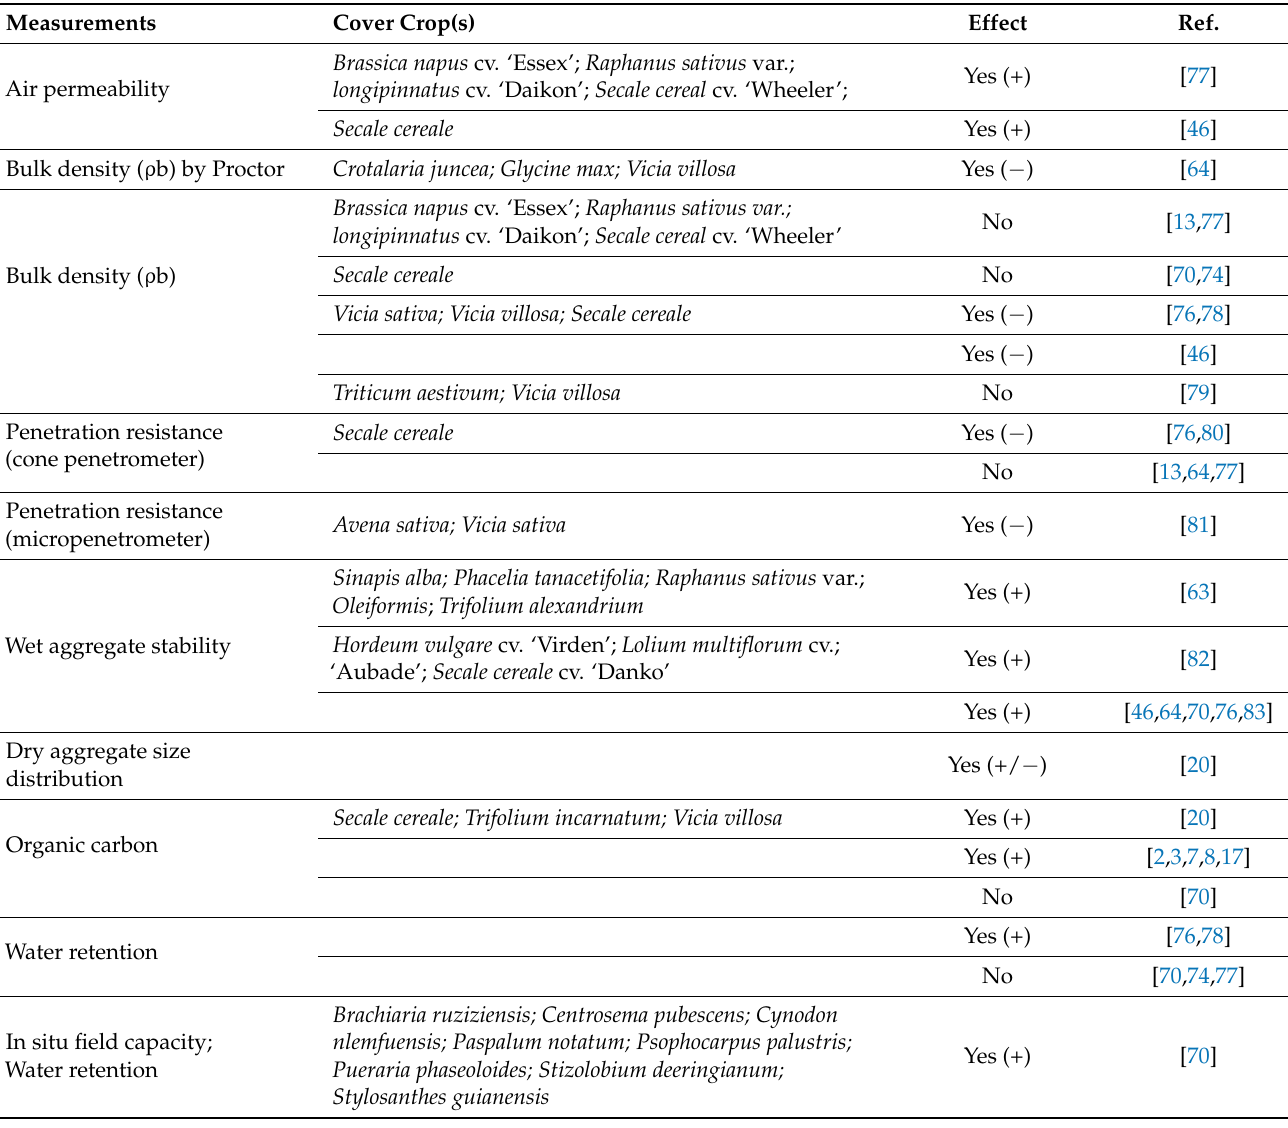
Table 1. Impact of cover crops on soil physical properties ( ρ b—bulk density; PSD—pore size distribution; K sat —saturated hydraulic conductivity) measured using various techniques for indirect estimation of root-soil interactions. Measurements Cover Crop(s) Effect